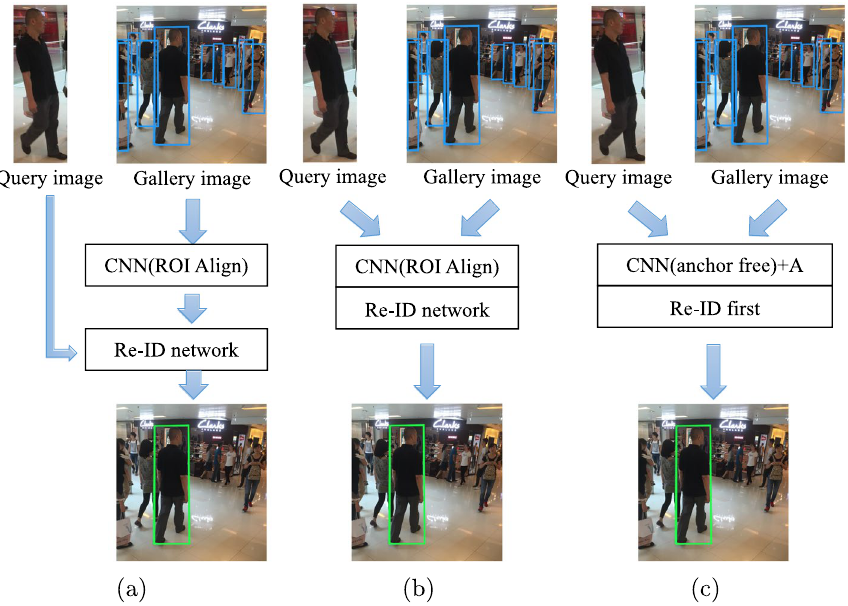
Fig. 1 Three different person search methods. a The traditional method first detects person in the gallery image and then estimates the re‑identification features to find the target. b The end‑to‑end training method for joint re‑identification and detection. c Our proposed ABOS